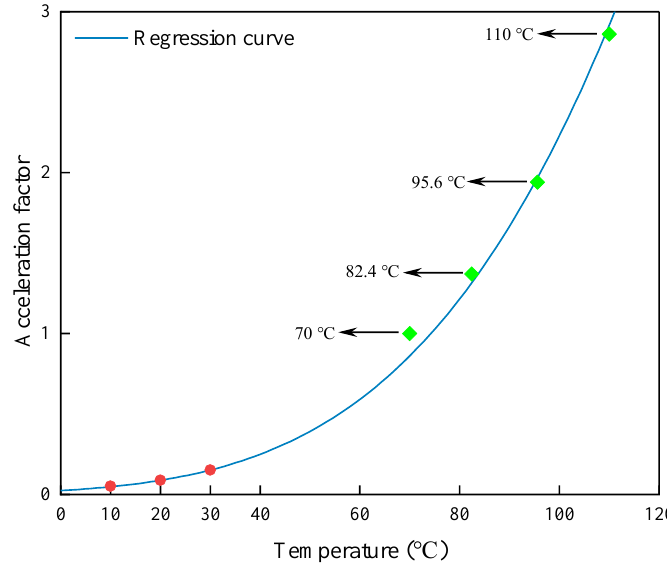
Figure 7. Regression and extrapolation results of the acceleration factors.